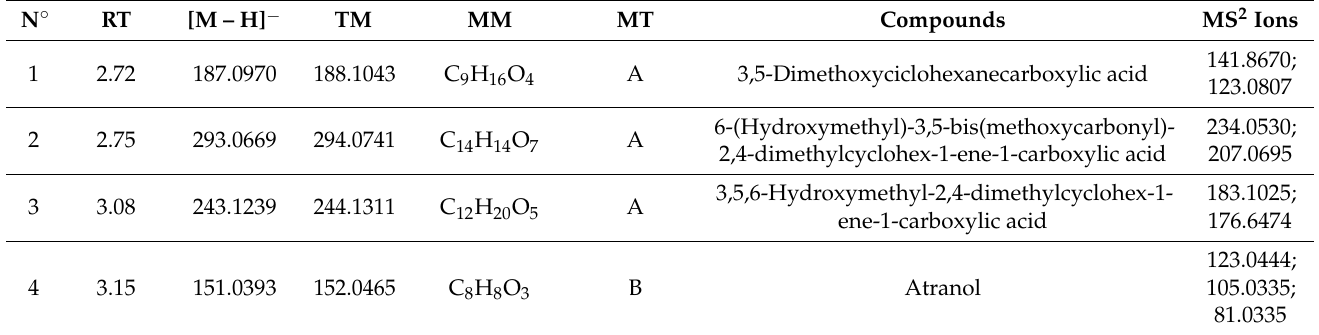
Table 3. Identification of metabolites in ME-hex of Physcia mediterranea by UHPLC/ESI/MS/MS. N ◦